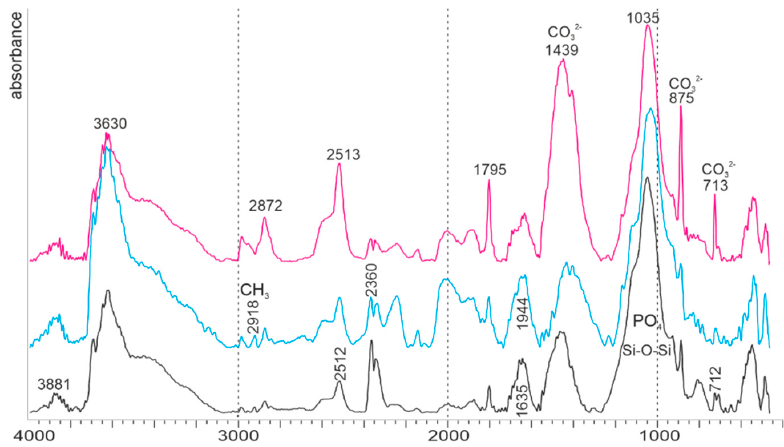
Figure 11. FTIR spectra of some samples of the sandy sediment, showing the presence of calcite, clays and probably bone fragments.